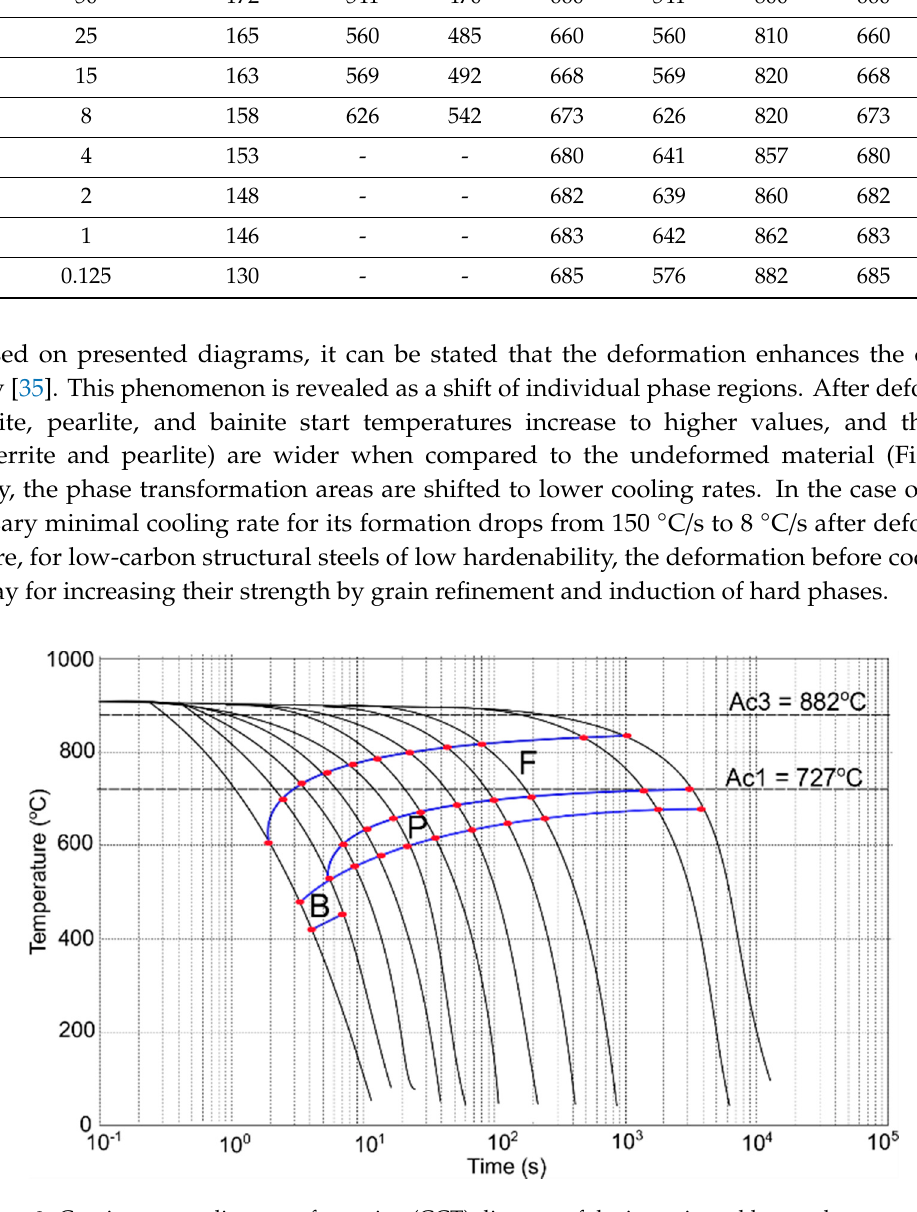
Table 5. Transformation start and finish temperatures are determined based on dilatometric analysis for deformed samples.